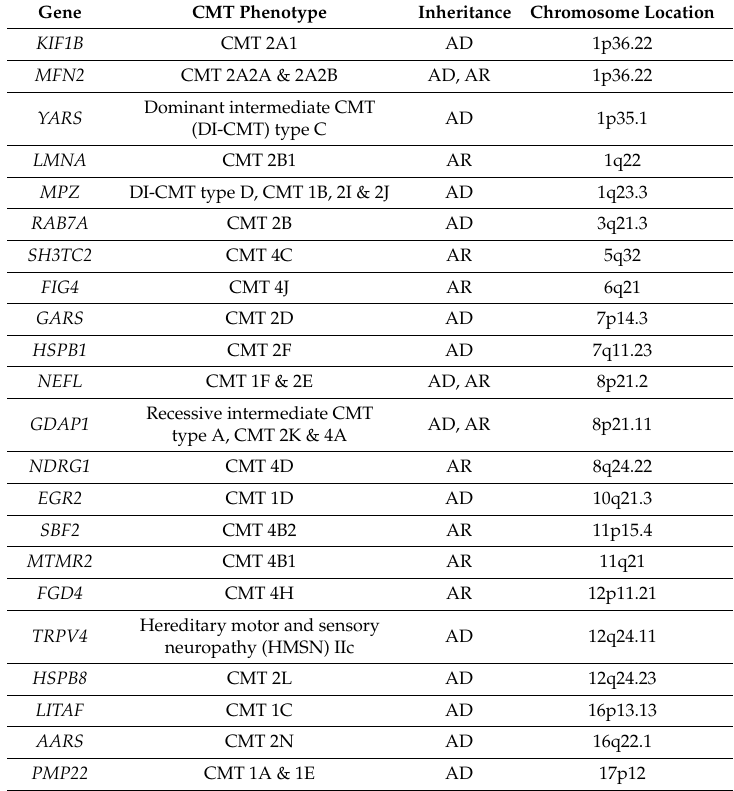
Table 1. Charcot-Marie-Tooth disease (CMT) 27-gene panel used in the current study. Gene CMT